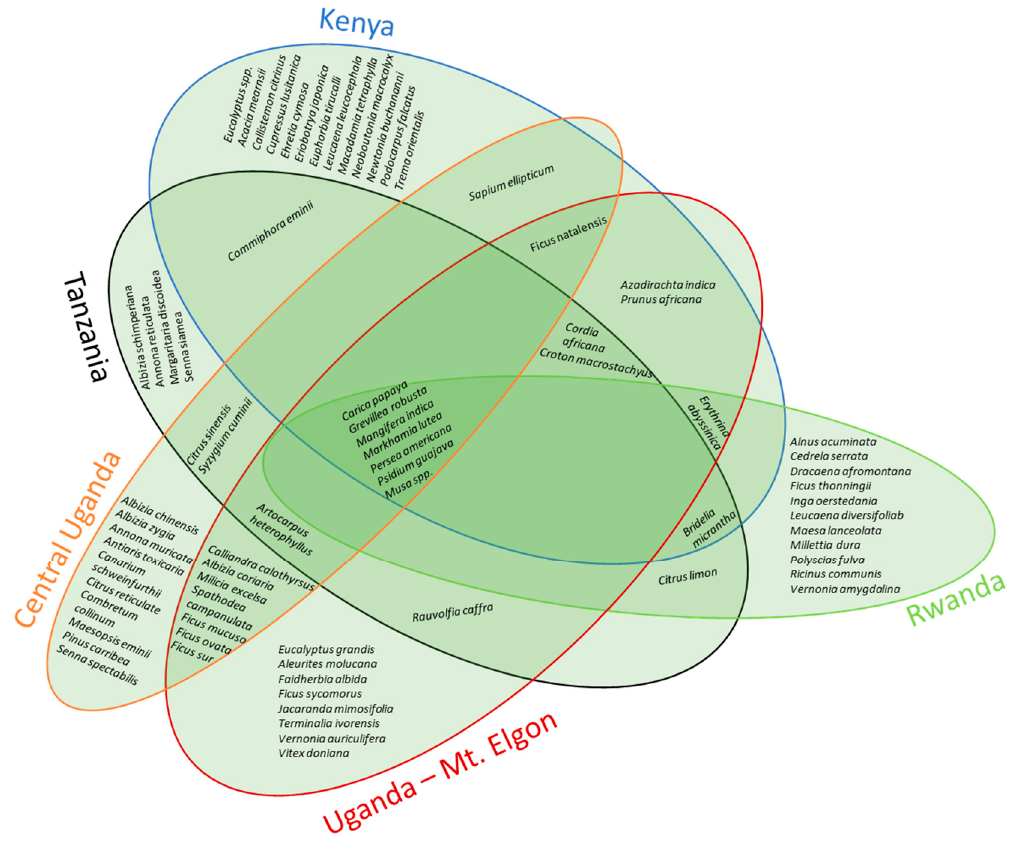
Figure 7. Shade species included in different rankings in East Africa [15,16,24,25].